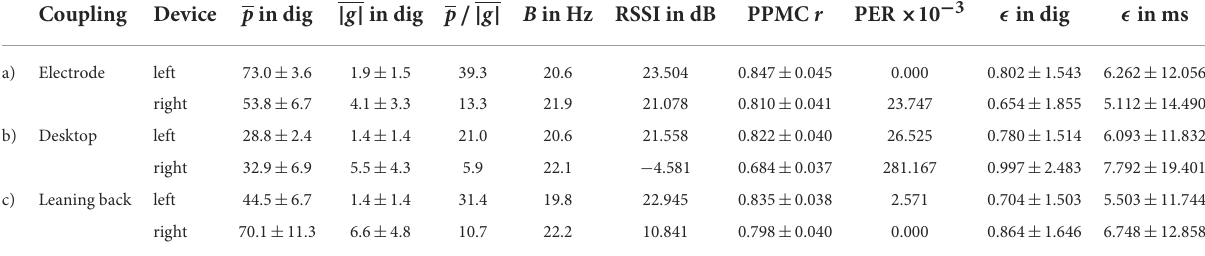
TABLE 1 Results of the